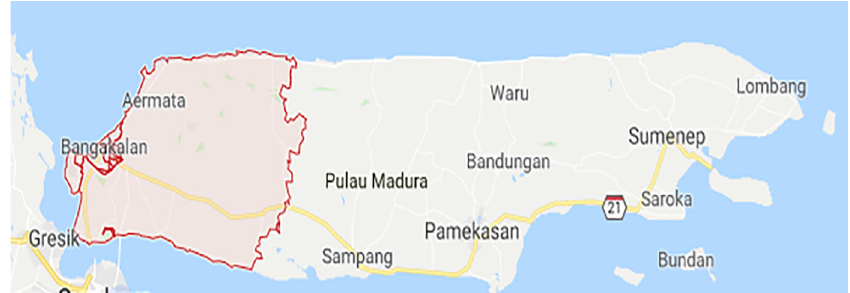
Figure 1. Bangkalan district, located in the western part of Madura